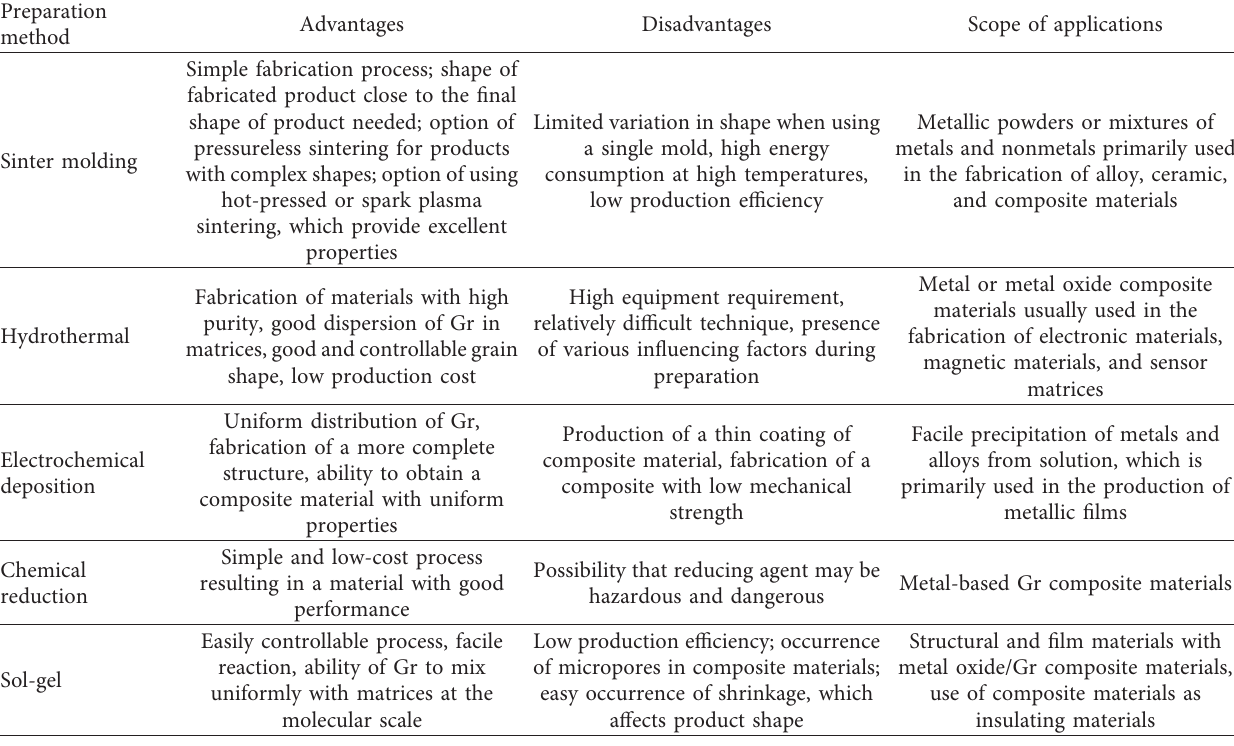
Table 1: Preparation methods, advantages, disadvantages, and the scope of application of graphene/inorganic composite materials [33–36]. Preparation